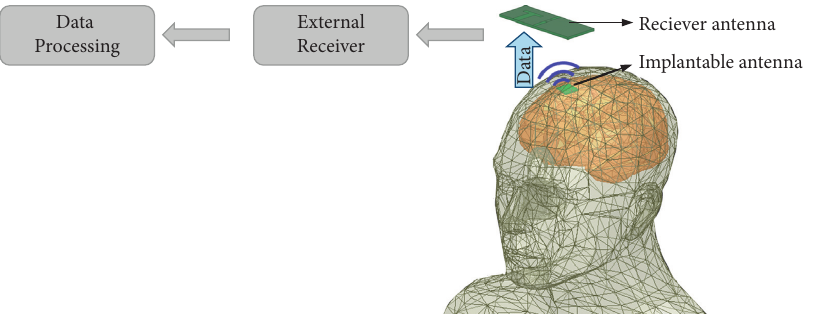
Figure 1: An overview of wireless brain implant